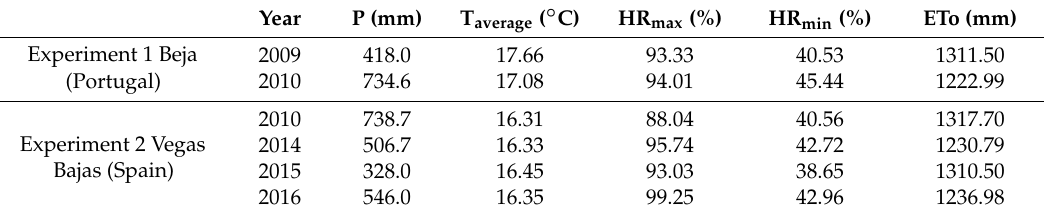
Table 1. Meteorological conditions for the studied years in Experiment 1 and 2; data represent the year